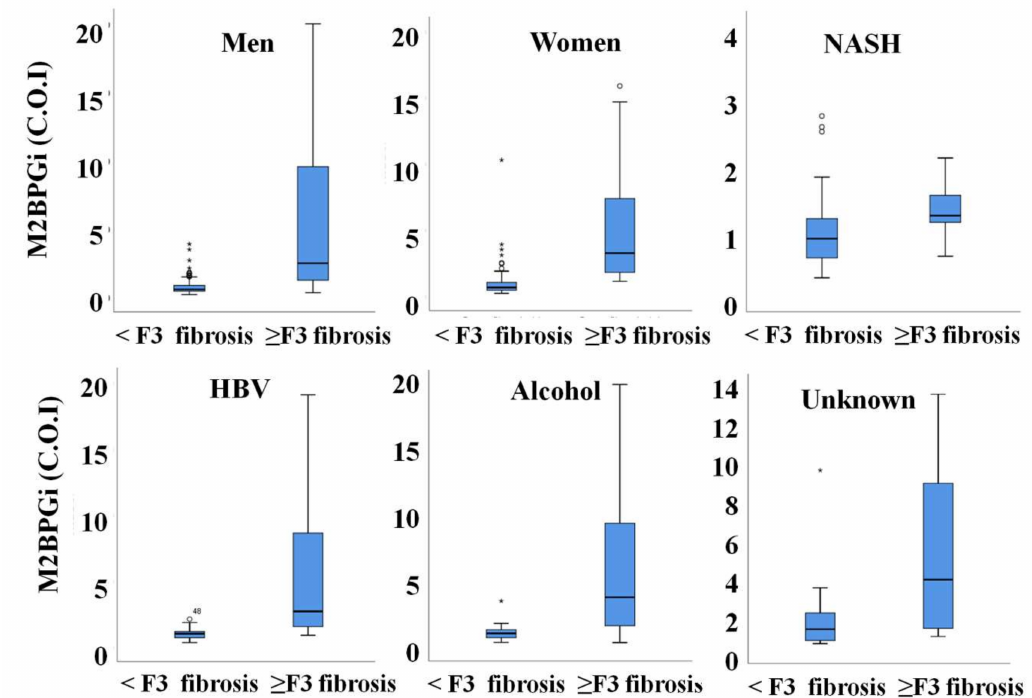
Figure 3. Comparison of M2BPGi concentration between subjects without advanced hepatic fibrosis and those with advanced hepatic fibrosis in men ( A ), women ( B ), non-alcoholic fatty liver disease ( C ), chronic hepatitis B ( D ), alcoholic liver disease ( E ), and unknown causes of liver disease ( F ).